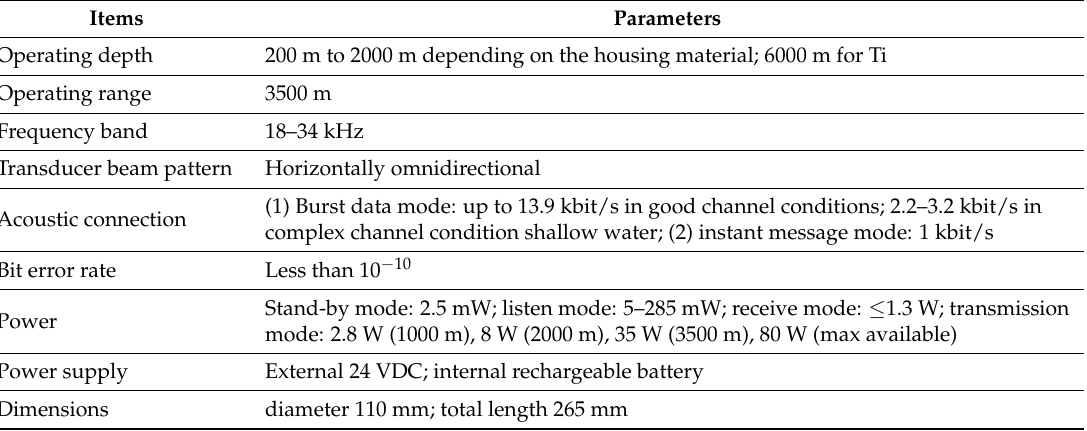
Table 2. Parameters of the S2CR communication